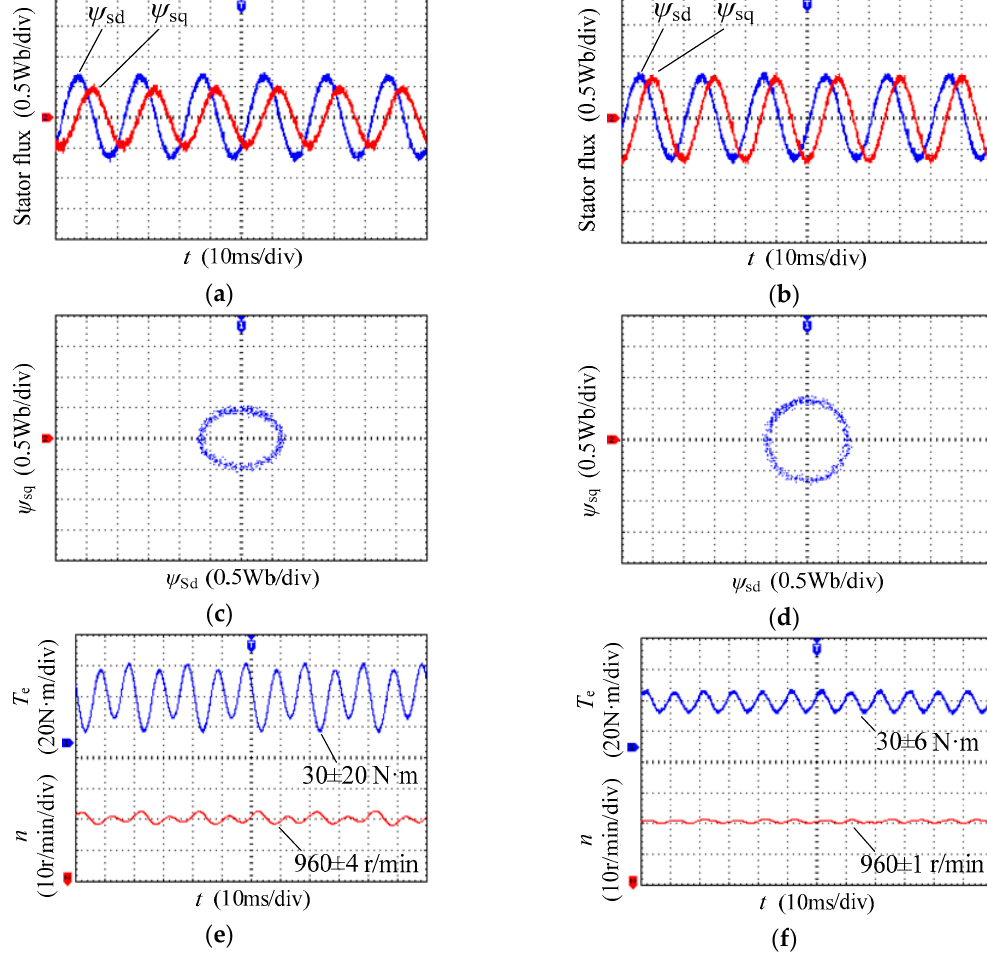
Figure 17. Fluxes, torques, and speeds in experiments 1 and 2. ( a ) d-q axis stator fluxes in experiment 1; ( b ) d-q axis stator fluxes in experiment 2; ( c ) Stator flux trajectory in experiment 1; ( d ) Stator flux trajectory in experiment 2; ( e ) Torque and speed in experiment 1; ( f ) Torque and speed in experiment 2. Table 3. FFT analysis results of steady-state voltages of remaining healthy stator phase winding. Voltages